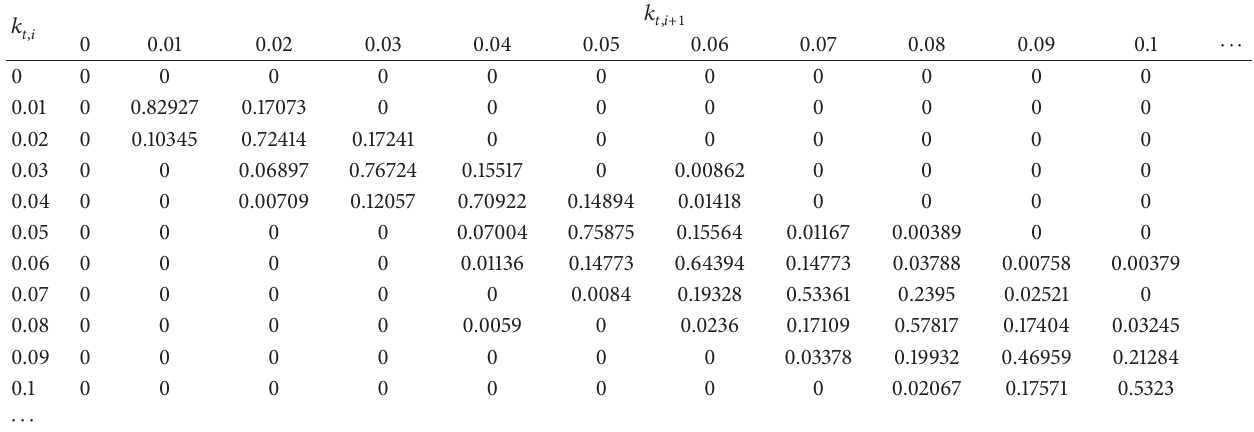
Table 2: Excerpt of an example TPM for broken clouds weather condition. For each 𝑘 𝑡 value at time i (rows), the probability of a switch to another 𝑘 𝑡 at time 𝑖 + 1 (columns) is given. The 𝑘 𝑡 values range from 0 to 2. 𝑘